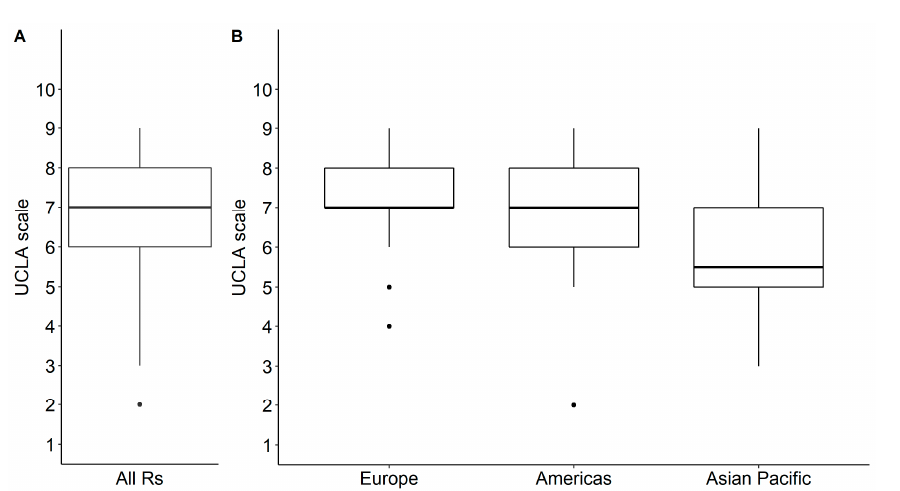
Figure 2. Box plot of responses to University of California, Los Angeles (UCLA) activity scale: ( A )